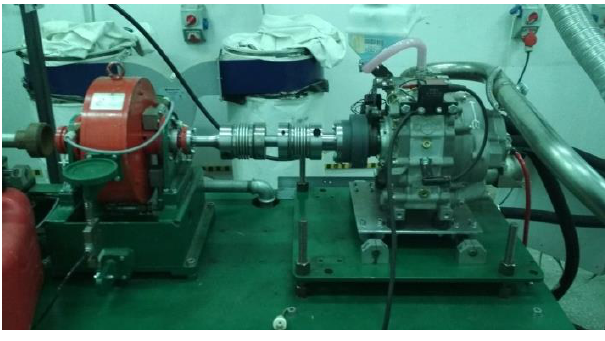
Fig. 5. Stand for testing engine characteristics The determined rotational characteristic, presented in Fig. 6.